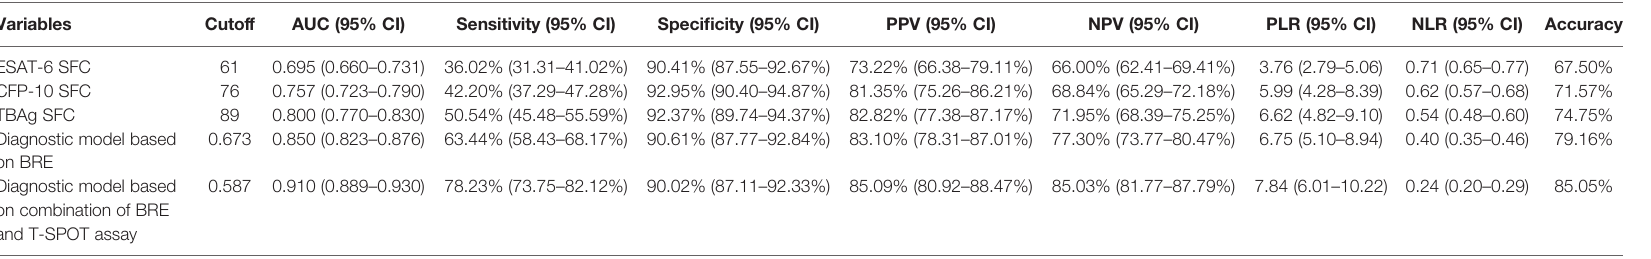
TABLE 4 | The performance of various methods for distinguishing between ATB and LTBI in Caidian cohort.